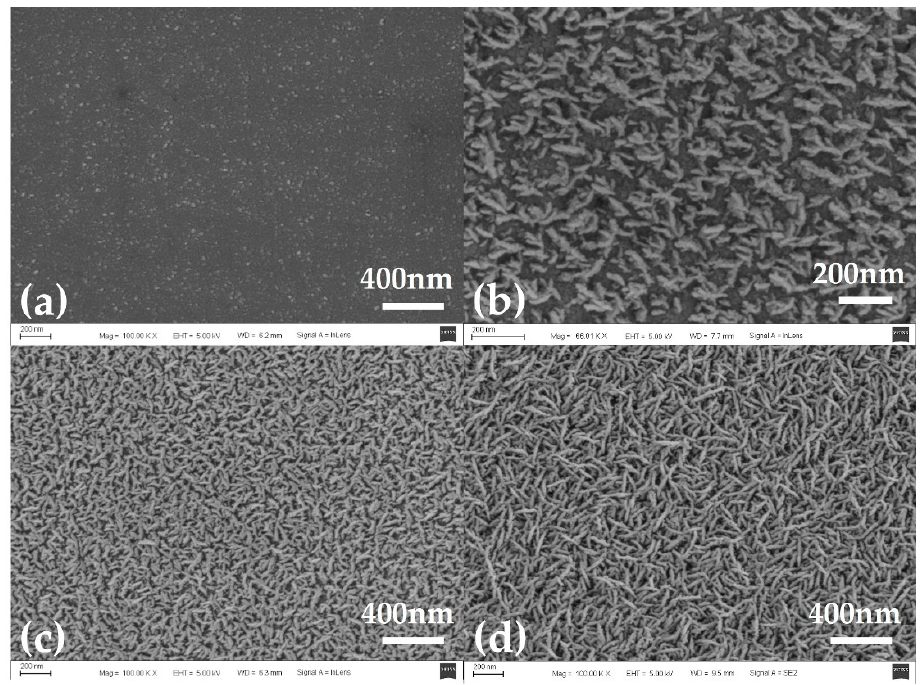
Figure 6. The surface morphology of iridium oxide films prepared with a sputtering time of ( a ) 1 min, ( b ) 3 min, ( c ) 5 min and ( d ) 15 min; the oxygen and argon flow rates were all maintained at 10 sccm during the sputtering process.